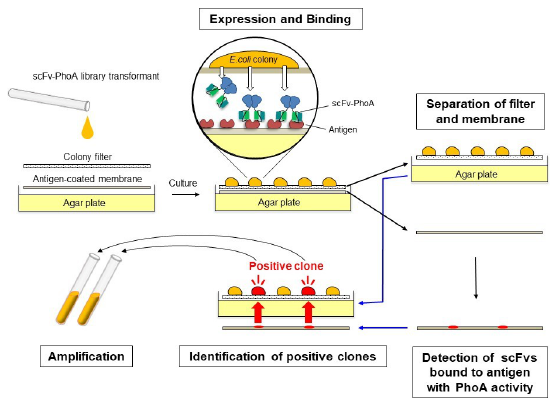
Figure 1. Schematic diagram of the procedure describing the colony assay with a single-chain variable fragment fused to the N -terminus of bacterial alkaline phosphatase (scFv-PhoA). ScFv-PhoA fusions are expressed and secreted from E. coli . Those with the desired affinity bind the antigen beneath the colonies and are detected directly after applying the alkaline phosphatase substrate. Positive clones are identified as the colonies matching the positive signals on the membrane.